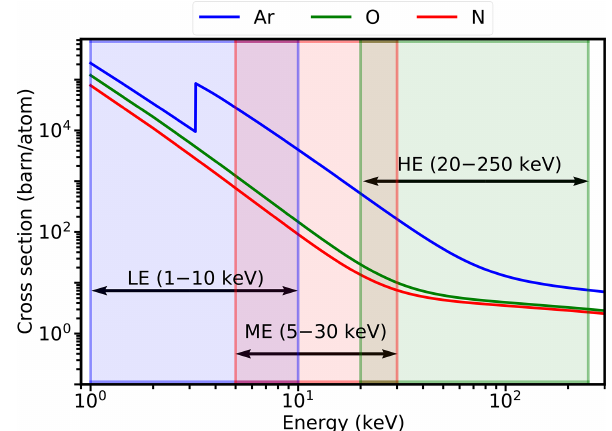
Figure 2. X-ray cross sections for Ar, O, and N. The energy ranges of LE, ME, and HE are indicated by shaded areas in light blue, light red, and light green to better distinguish the cross sections of each energy range. LE, ME, HE, and their respective energy ranges are also marked by bidirectional arrows. The calibrated energy range of LE is shown. A barn is a unit of area where 1 barn = 1cm − 24